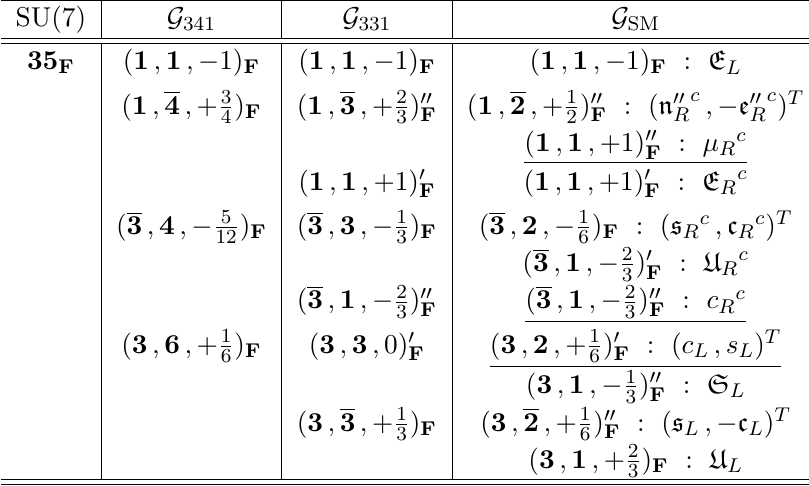
Table 4 . The SU(7) fermion representation of 35 F under the G 341 , G 331 , G SM subgroups for the SU(7) model. All SM fermion names and irreps are identified with